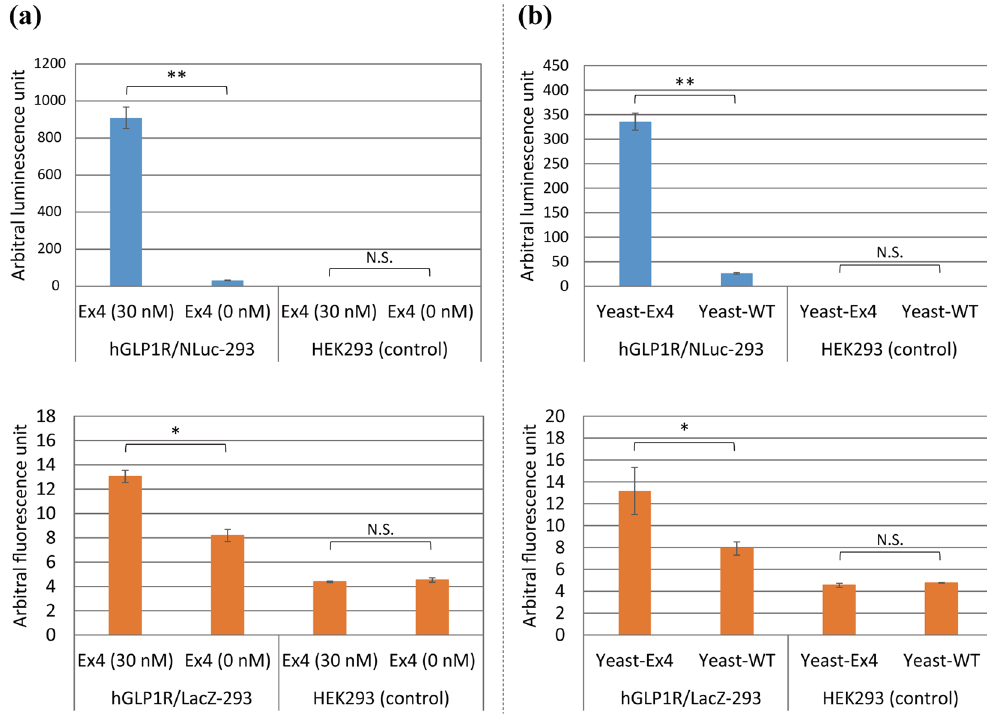
Figure 2. Functional cell-based assay for evaluating the reporter cell lines. ( a ) Functional cell-based assay using authentic exendin-4 (Ex4). hGLP1R/NLuc-293 and hGLP1R/LacZ-293 were cultured in DMEM media with or without 30 nM authentic Ex4. WT HEK293 was used as a control. Values are mean ± SD (n = 3). Two-tailed Student’s t -test was used to compare two groups ( * p < 0.05, ** p < 0.01). N.S., not significant. ( b ) Functional cell-based assay using culture supernatants of yeast cells secreting Ex4. hGLP1R/NLuc-293 and hGLP1R/ LacZ-293 were cultured in DMEM media with culture supernatants of yeast cells producing Ex4 (Yeast-Ex4) or WT yeast cells (Yeast-WT). Values are mean ± SD (n = 3). Two-tailed Student’s t -test was used to compare two groups ( * p < 0.05, ** p < 0.01). N.S., not